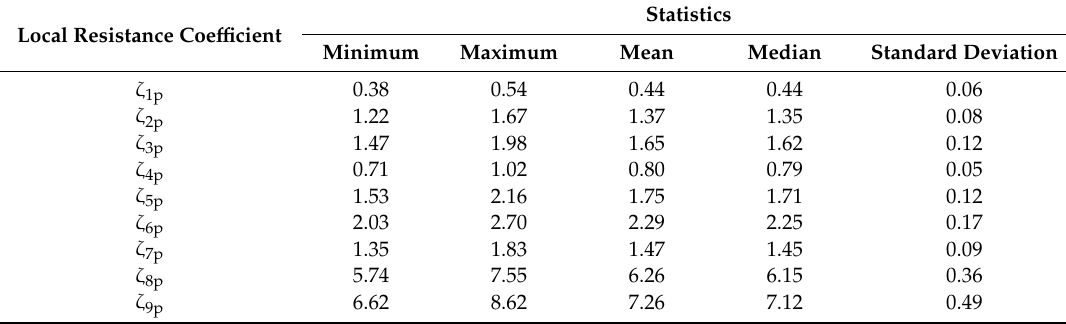
Table 1. Basic statistics of the local resistance coe ffi cients ζ determined from the measurements of the polypropylene T-junctions.